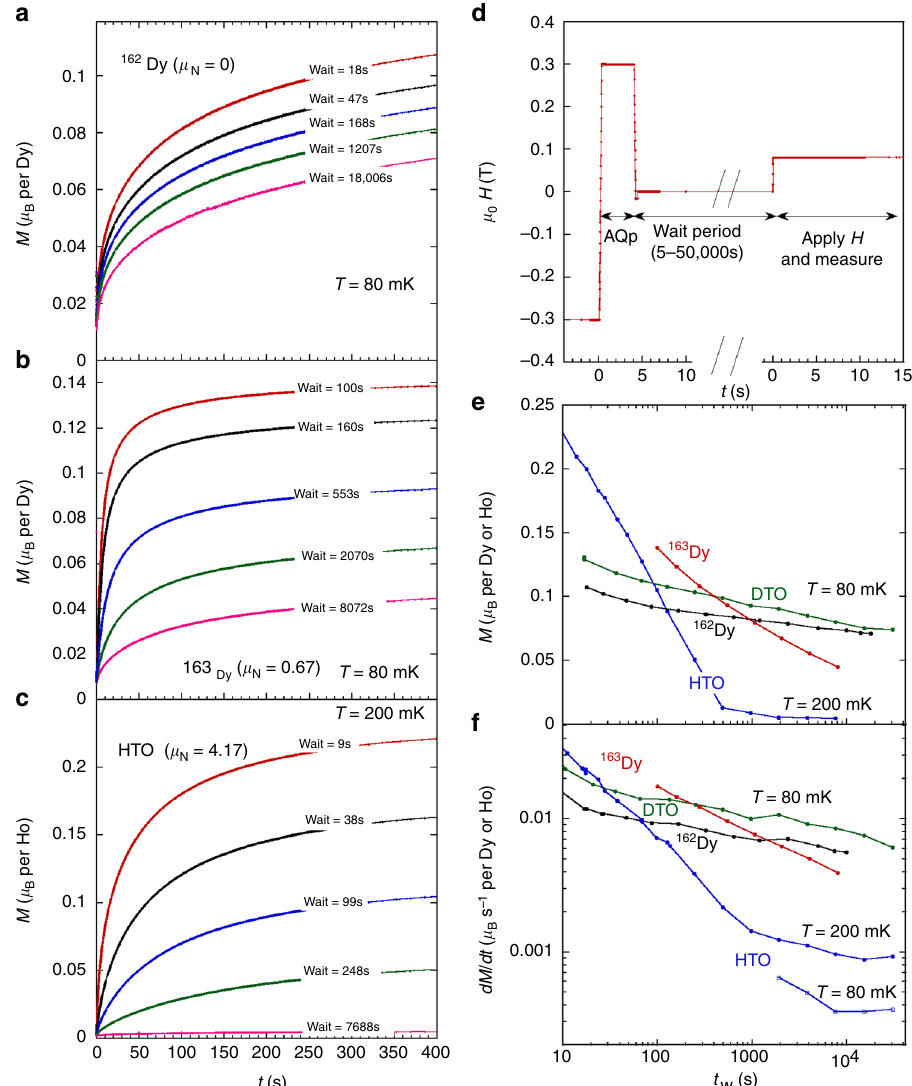
Fig. 3 Spontaneous evolution of the monopole density during a wait time in zero applied fi eld. This is gauged by the growth of magnetisation ( M ) and monopole current density ( J m = dM / dt ) after a fi eld is applied; comparison of the different isotopic samples reveals the effect of nuclear spins on the monopole mobility. a 162 Dy 2 Ti 2 O 7 ( 162 Dy) and b 163 Dy 2 Ti 2 O 7 ( 163 Dy), both measured at T = 80 mK, and c Ho 2 Ti 2 O 7 (HTO, T = 200 mK). nat Dy 2 Ti 2 O 7 (DTO) can be seen in Supplementary Fig. 4. The samples were fi rst prepared using the AQP protocol outlined in ( d ) and discussed further in Methods. After the speci fi ed wait periods, a fi eld of 0.08 T was applied and the magnetisation as a function of time was recorded. All measurements shown in the fi gure were made with the fi eld along the [111] axis; examples for other directions are given in the Supplementary Figs. 10 and 11. e Plot of the value of the magnetisation M obtained after the fi rst 400s for the three samples shown to the left, and for nat Dy 2 Ti 2 O 7 vs. log wait time. Note that the magnetisation values at 400 s remain far from the expected equilibrium value. f The monopole current J m = dM / dt at t = 0 for the three samples shown to the left vs. log wait time. Also shown is the monopole current for nat Dy 2 Ti 2 O 7 , and the monopole current for Ho 2 Ti 2 O 7 measured at 80